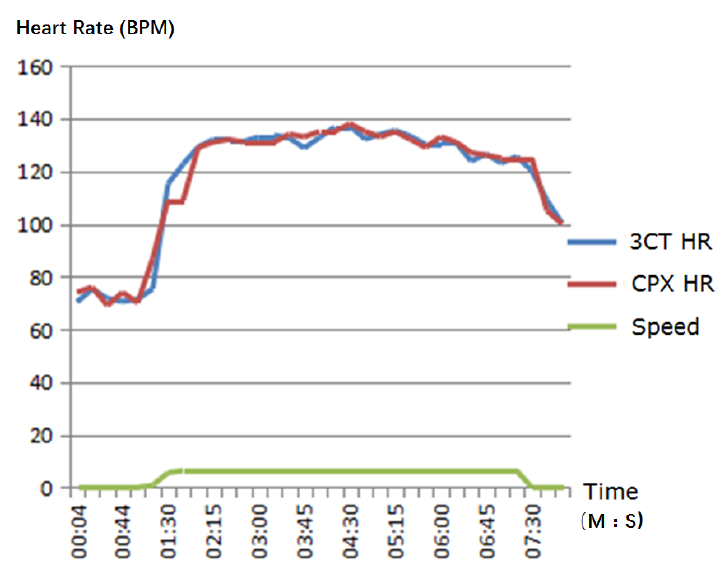
Figure 4. Heart rate comparison along 8 min of exercise test time.